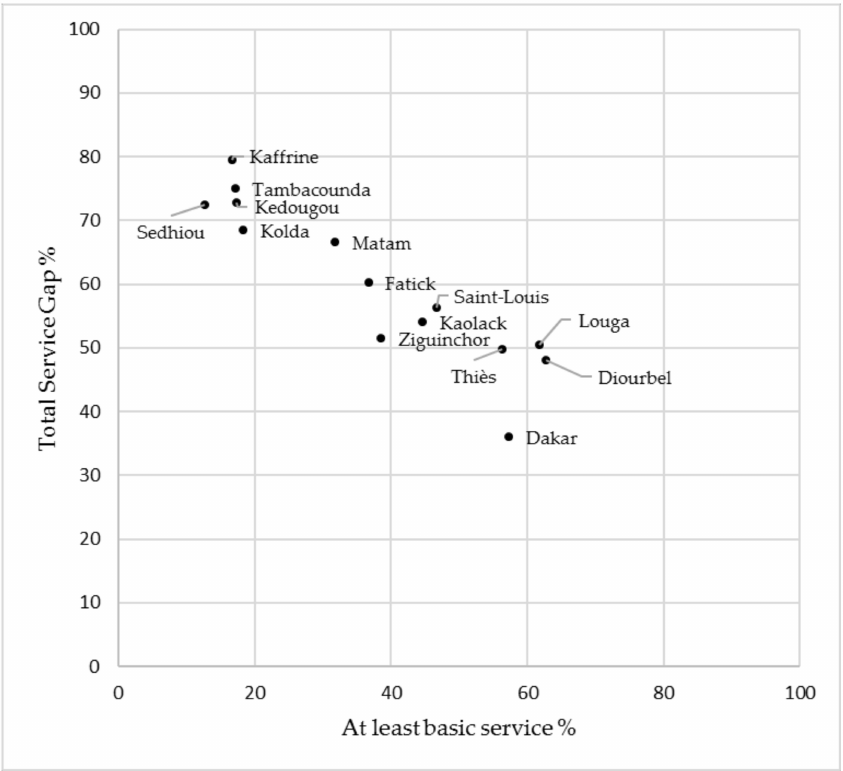
Figure 4. Comparison of the total service gap for sub-national regions of Senegal,